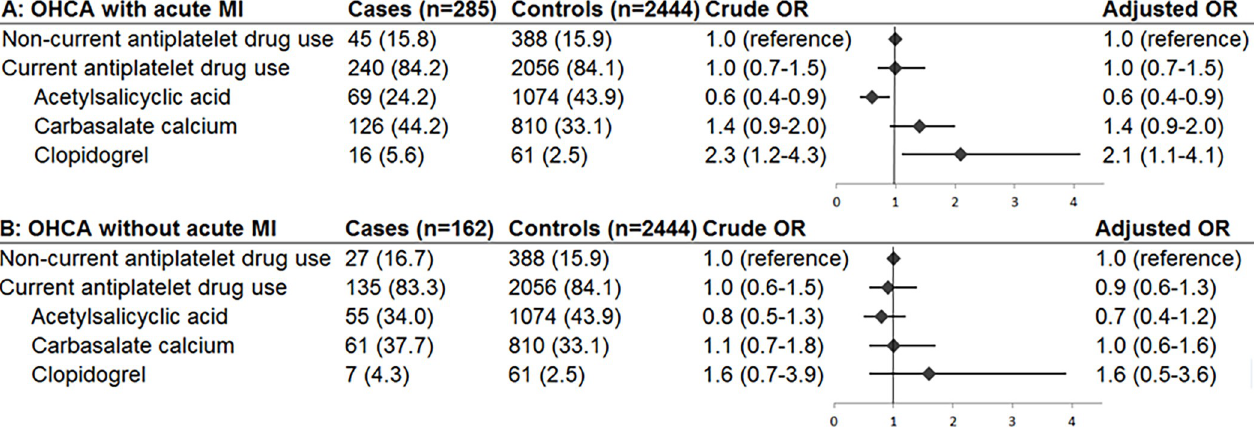
Fig 4. Current use of antiplatelet drugs and the risk of out-of-hospital cardiac arrest with acute myocardial infarction as the cause (A) and without acute myocardial infarction as the cause (B). Not included in the figure: current users of other antiplatelet monotherapy (e.g., dipyridamole, ticlopidine) among cases and controls, and current users of � 2 antiplatelet drugs among cases and controls. Abbreviations: CI, confidence interval; MI, myocardial infarction; OHCA, out-of-hospital cardiac arrest; OR, odds ratio. Numbers in table are number (%) unless indicated otherwise. Error bars denote 95% confidence interval.